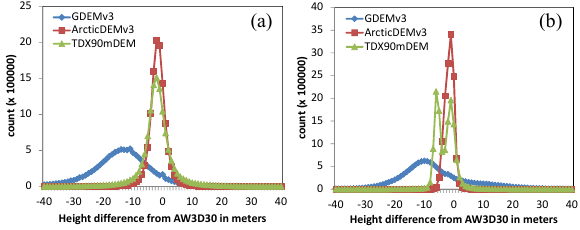
Figure 5. Histograms of height differences from